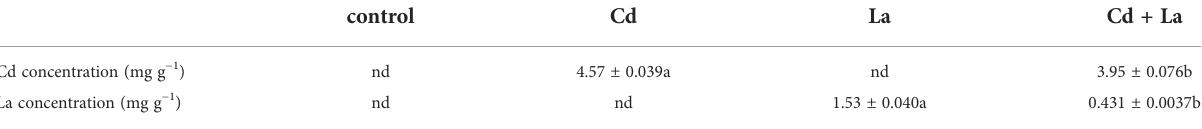
TABLE 1 Cd and La accumulated concentrations in the thalli of G. bailiniae .